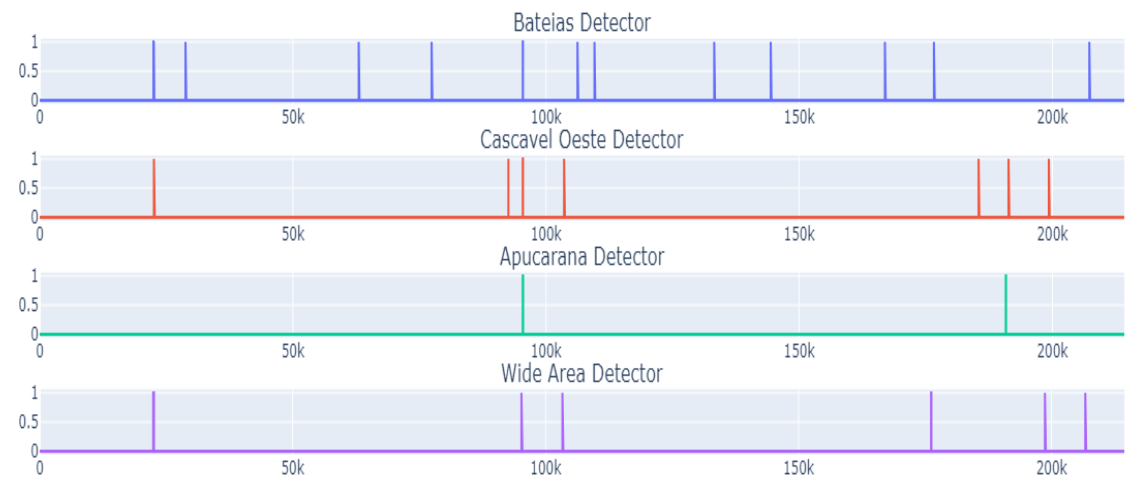
Figure 11. Event 1: PMUS detectors and final detector.